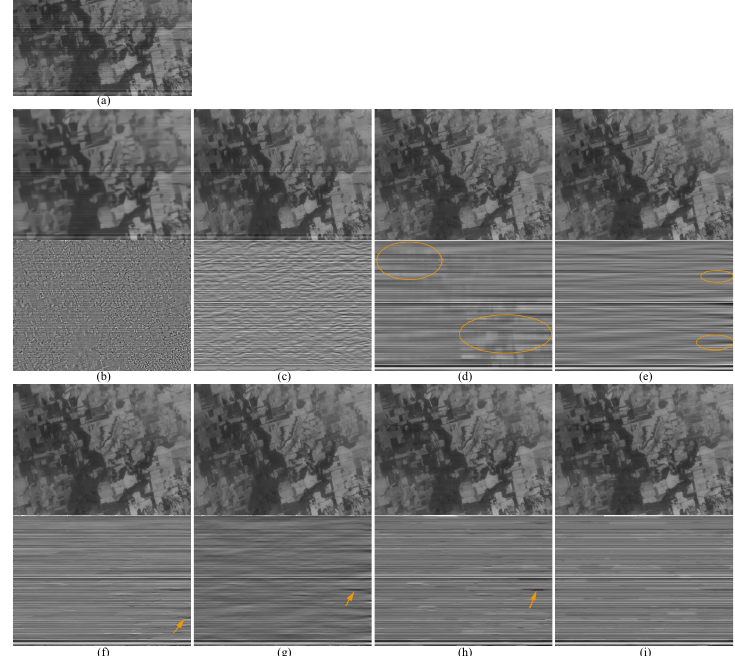
Figure 22. Results of different methods on Hyperion data band 135 R6. ( a ) original; ( b ) BM3D; ( c ) SNRCNN; ( d ) GF-based; ( e ) WAFT; ( f ) UV; ( g ) HUTV; ( h ) SUV; ( i ) WDSUV. In each result, the top part is the destriping result, and the bottom part is the corresponding stripe noise